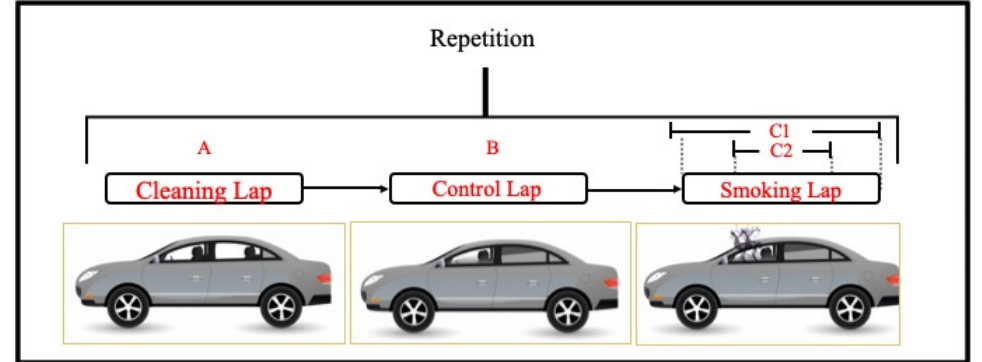
Figure 2. Car measurement methodology.